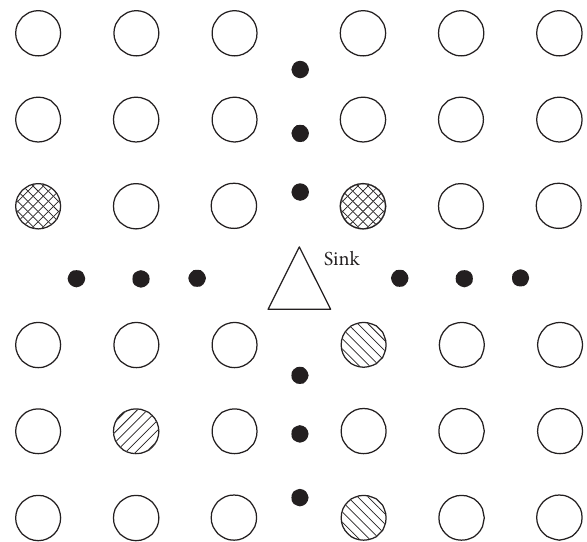
Figure 8: The initial node selection in wireless sensor